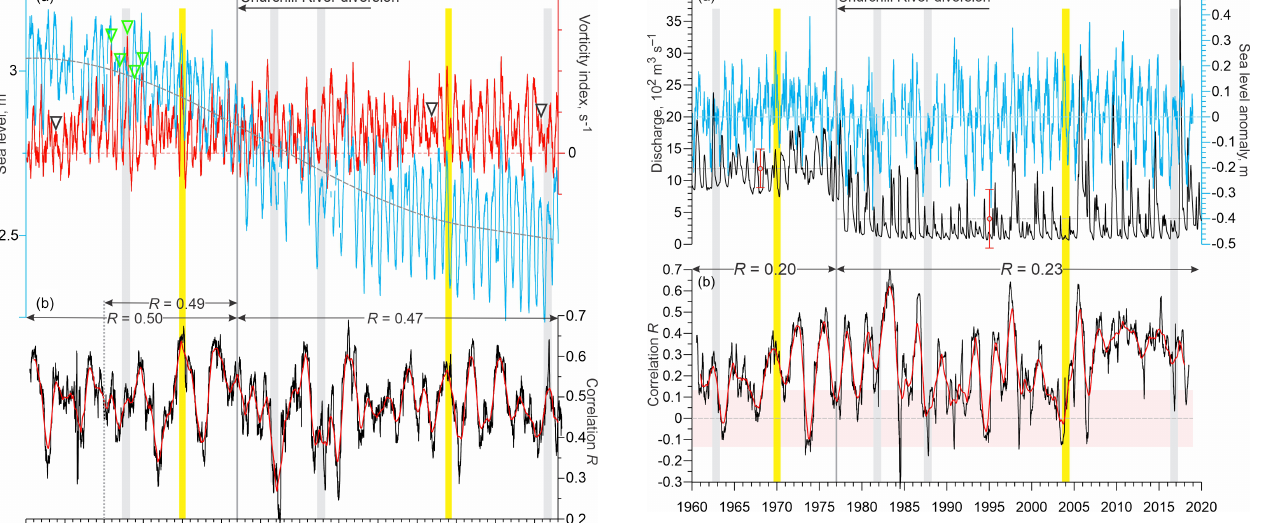
Figure 3. (a) 91d running mean of daily mean atmospheric vor- ticity index (red,s − 1 ) over Hudson Bay and sea level measured at the tide gauge in Churchill (blue,m). Positive and negative vor- ticity correspond to cyclonic and anticyclonic atmospheric circu- lation, respectively. Gray dashed line shows polynomial approxi- mation of the sea-level trend attributed to the glacial isostatic ad- justment. Black and green triangles show periods when seasonal vorticity from late fall to early winter was diminished and ampli- fied, respectively. (b) Correlation R between daily vorticity index and sea-level anomaly (SLA) computed for the 365d moving win- dow (black) with their 365d running mean (red). All correlations are statistically significant at 99% confidence. Numbers at the top show correlation between daily vorticity index and SLA computed for 1950–1976 and 1960–1976 and for 1977–2018 pre- and post- diversion, respectively. (a, b) Yellow shading highlights August– May 1969–1970 and 2003–2004, enlarged in Fig. 6. Black arrow indicates onset of the Churchill River diversion. Gray shading high- lights periods when the sea-level seasonal cycle was partially dis-